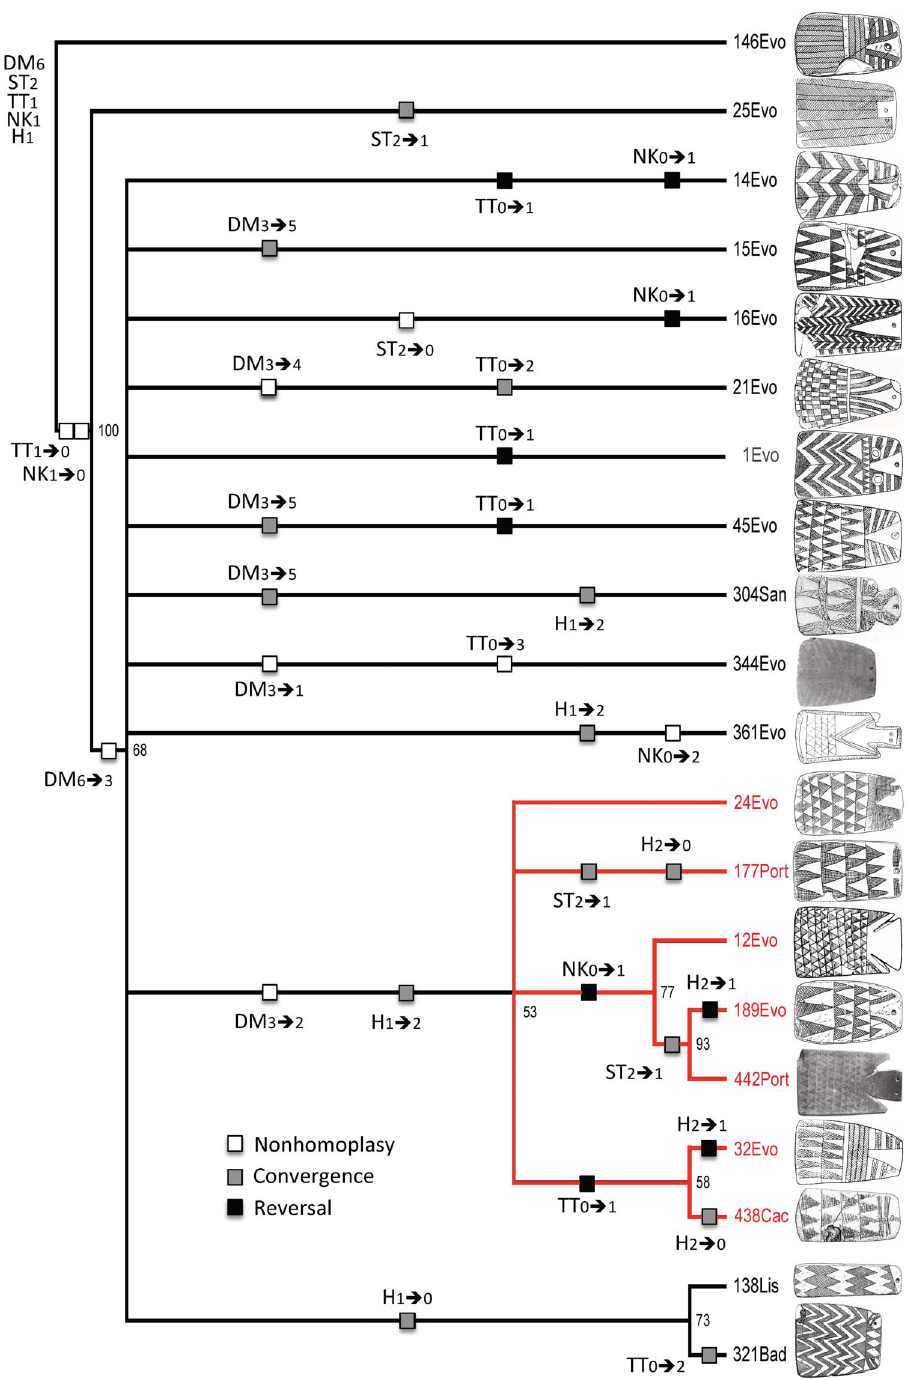
Figure 6. Fifty-percent majority-rule consensus tree from exercise 2, sample 3. The tree, which uses weighted characters but unordered character states, has a CI of 0.594, an RI of 0.658, and an RC of 0.391. When generated by PAUP, the tree was unrooted, but it subsequently was rooted with class 146 to resolve the topology in favor of Lillios’s hypothesis. Numbers at nodes are bootstrap values.